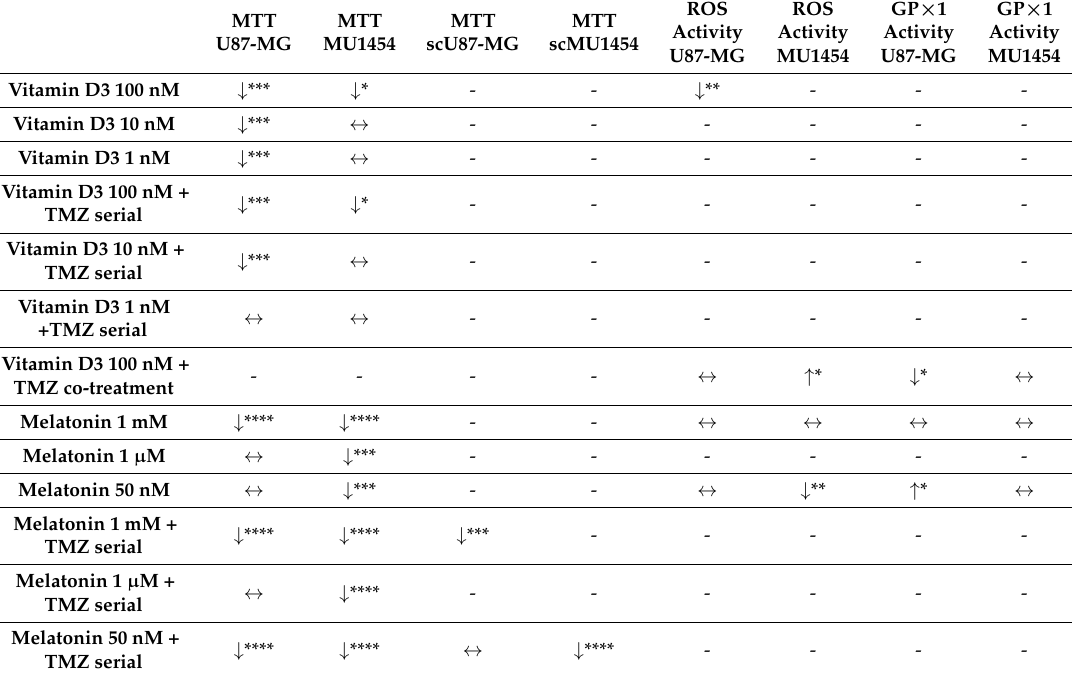
Table 1. Summary of Assays with Anti-oxidant Treatments with or without 100 µ M